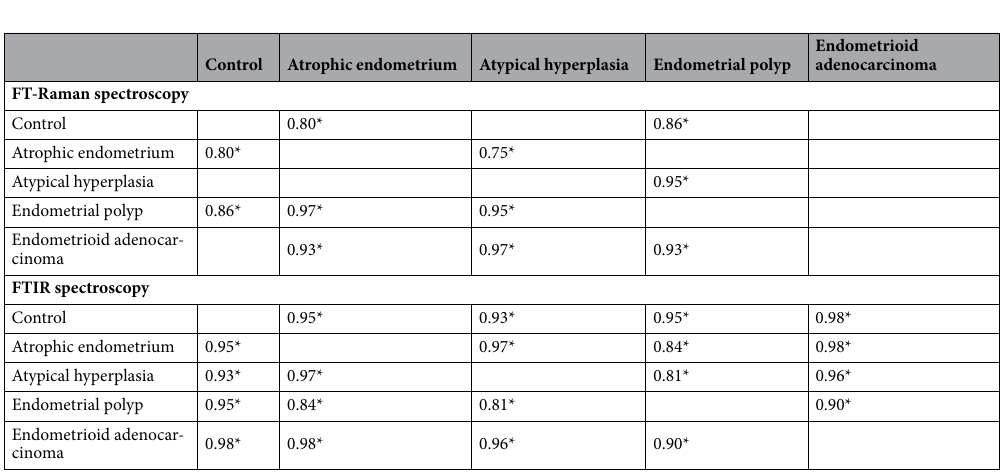
Table 4. Pearson correlation ( p < 0.05) test for Raman and FTIR spectra. *Statistically significant, when p <